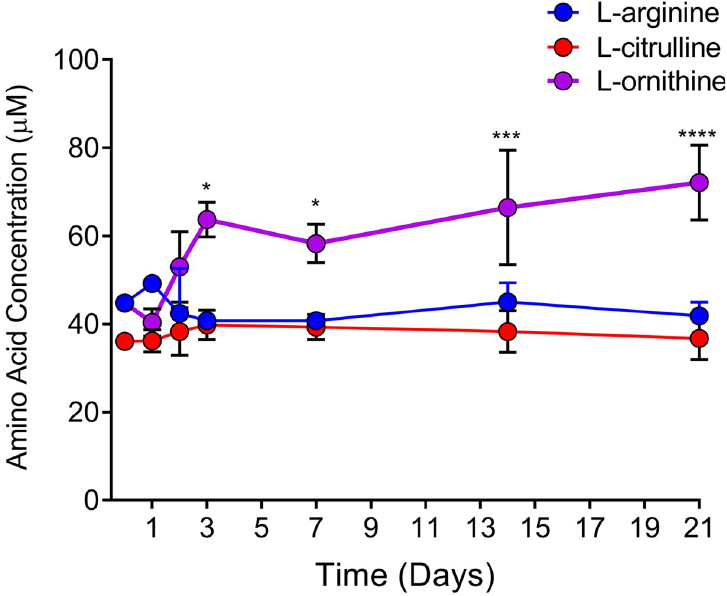
Fig 5. L-ornithine, but not L-arginine or L-citrulline plasma levels become elevated during B . burgdorferi infection. Outbred Swiss webster mice were infected with wild-type B . burgdorferi and plasma concentrations of L- arginine, L-citrulline, and L-ornithine were quantified by HPLC analysis. Individual, one-way ANOVAs with Tukey’s multiple comparison test were performed to evaluate significant changes in amino acid concentration over time. Asterisks indicate p-value �